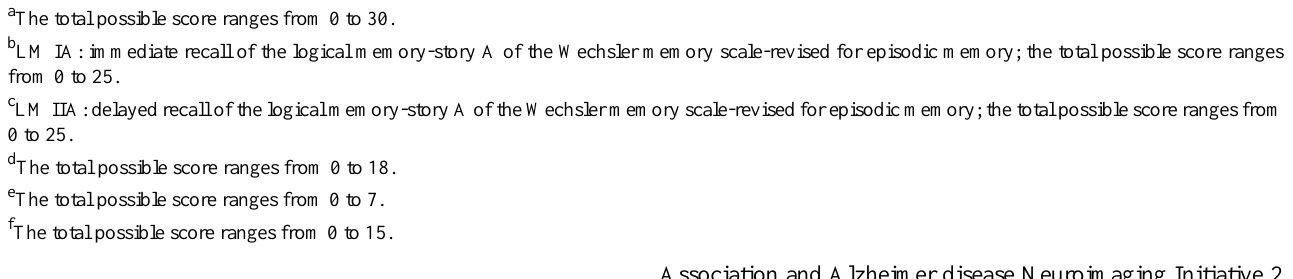
P valueIndividuals with accident or